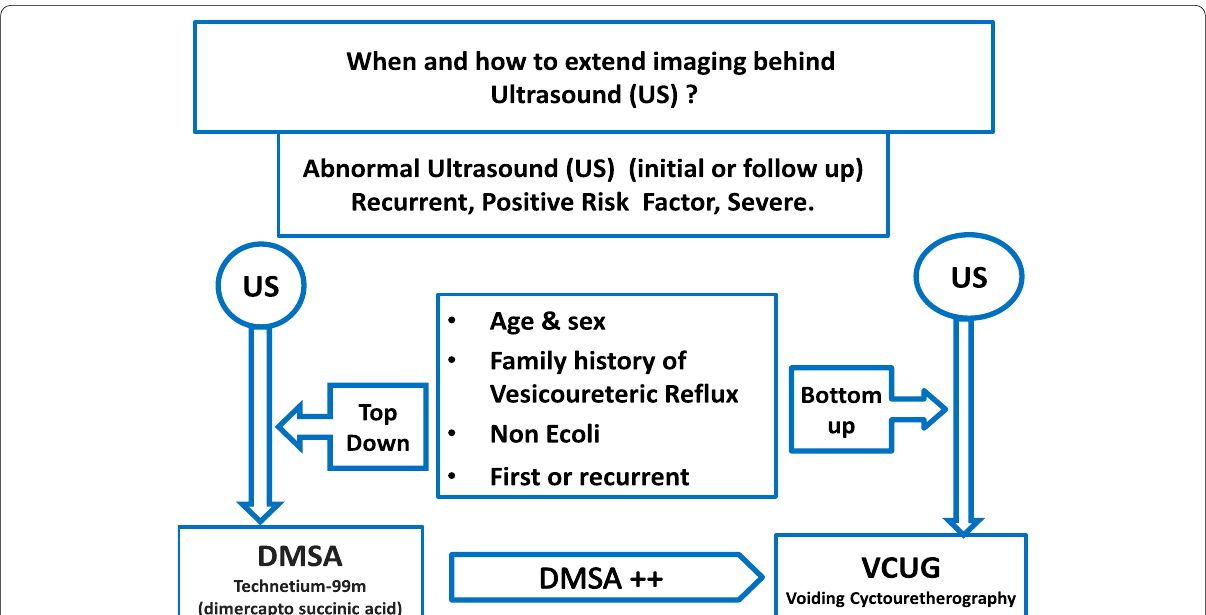
Fig. 5 When to extend imaging? Bottom-up or top-down approach? Factors to be considered in choosing the bottom-up or top-down approach include age, sex, first or recurrent, non- E . coli , and family history of vesico-ureteric